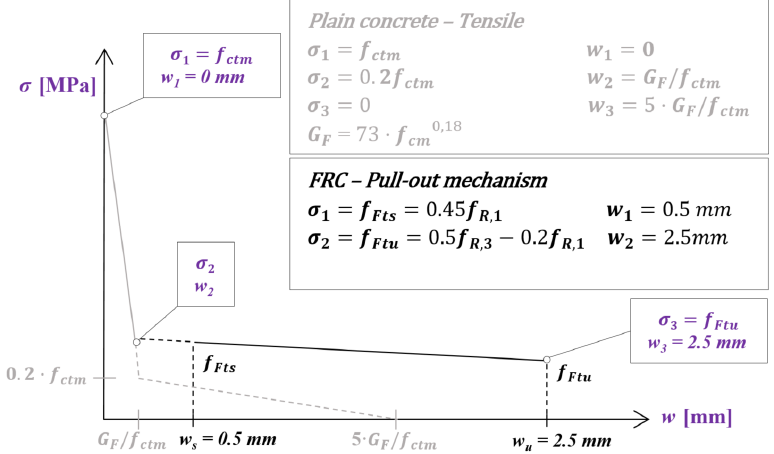
Figure 6. fib MC-2010 [1] FRC tensile constitutive equation.